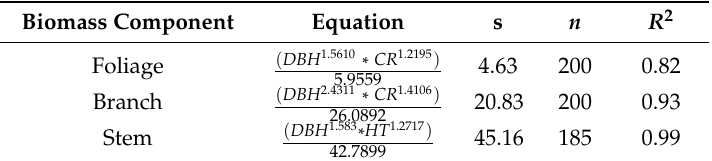
Table 3. Douglas-fir biomass allocation